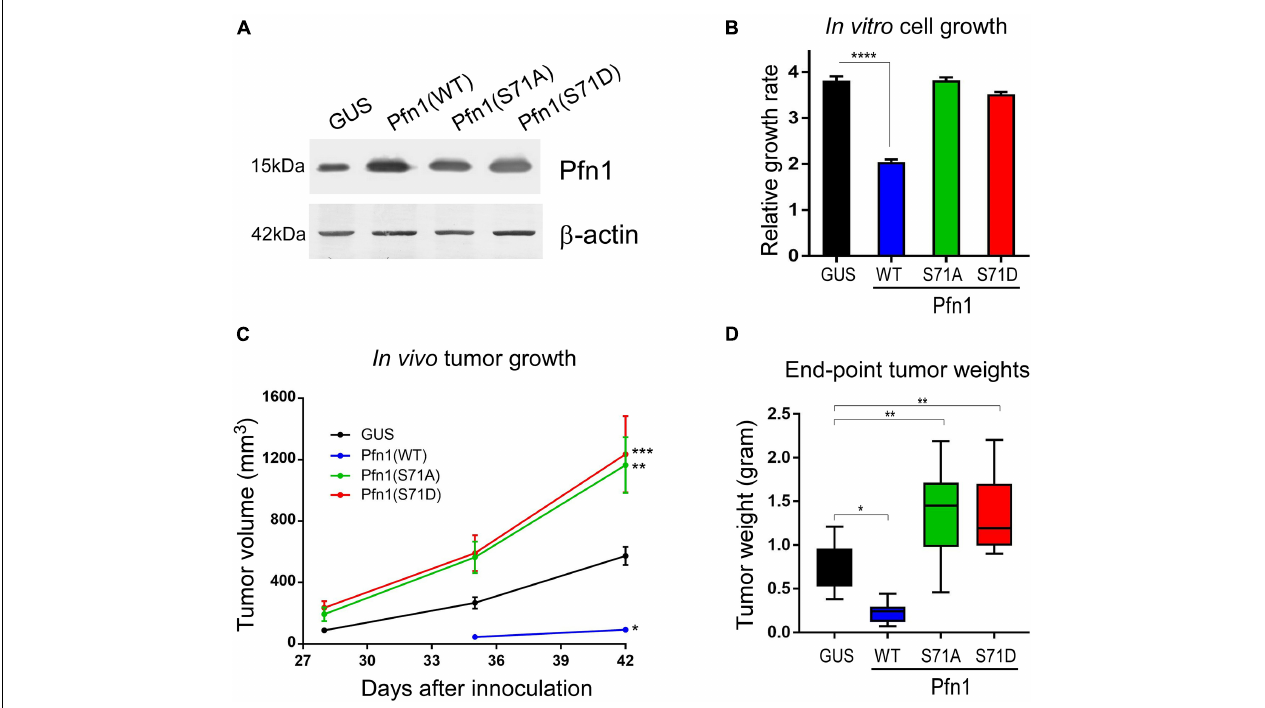
FIGURE 4 | Preventing and mimicking Ser 71 phosphorylation similarly abolish the antitumor activity of Pfn1. (A) Western blot analysis of exogenous wild type and mutant Pfn1 expression in stable MDA-MB-231 cells using a pan Pfn1 antibody, controlled by actin. (B) Stable MDA-MB-231 cells from A were seeded in 96-well plates and grown for 7 days. Relative growth rates were calculated by normalizing Alamar blue values of each subline at Day 7 to those at Day 1. Data are mean ± SEM of four technical replicates in one experiment. P -values were based on two-tailed unpaired t -test. Same results were confirmed by more than three independent experiments. (C) Stable MDA-MB-231 cells were injected bilaterally into the 4th mammary fat pads of 5-week-old female NOD/SCID mice (10 6 cells per side, five mice per group). Caliper measurement of tumor volumes started at 4 weeks after injection. Data are the mean ± SEM of 10 tumors within each group. P -values were based on two-tailed unpaired t -test (versus GUS control) at day 42. (D) End-point tumor weights. Data are the mean ± SEM. P -values were based on two-tailed unpaired t -test (versus GUS control). * p < 0.05; ** p < 0.01; *** p < 0.001, **** p < 0.0001. GUS and Pfn1(WT) tumor values were published in our prior study (Diamond et al., 2015) as they were the same controls for Pfn1(S137A vs. S137D) (published) and Pfn1(S71A vs. S71D) (shown here, unpublished) in the same mouse xenograft